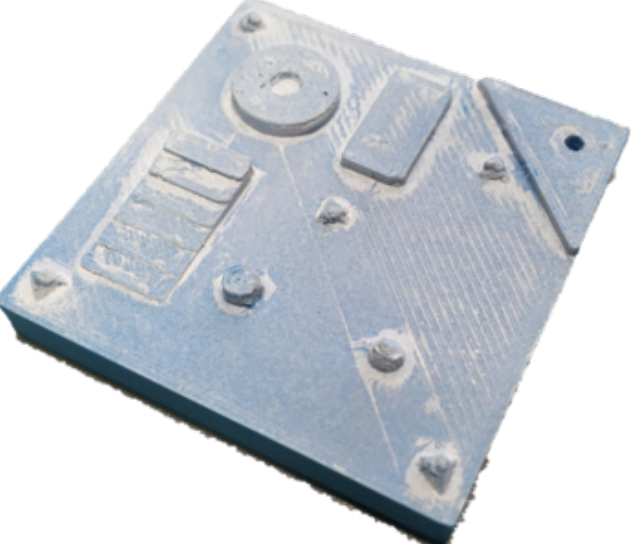
Figure 3. 3D printed Imaging target of 40 mm by 40 mm with rectangular, spherical and cilindrical features.